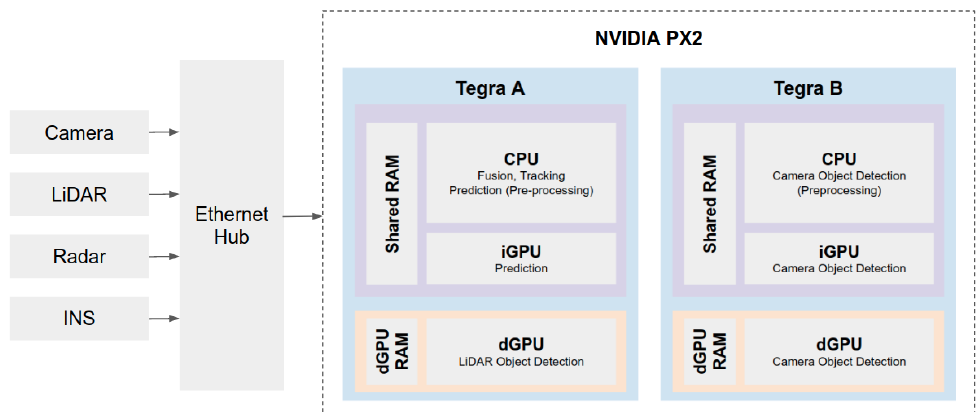
Figure 4. Overview of the dataflow and memory allocation on the Nvidia PX2. Raw data from the sensors are plugged into an ethernet switch connected to our Nvidia PX2. In the Nvidia PX2, we show the memory allocation for computation of the four modules. (1) Prediction module is done in the CPU and iGPU of Tegra A. (2) LiDAR object detection is done in the dGPU of Tegra A. (3) Sensor fusion and object tracking module is done in the CPU only to reduce requirements on the GPU memory. (4) Camera object detection is done solely in Tegra